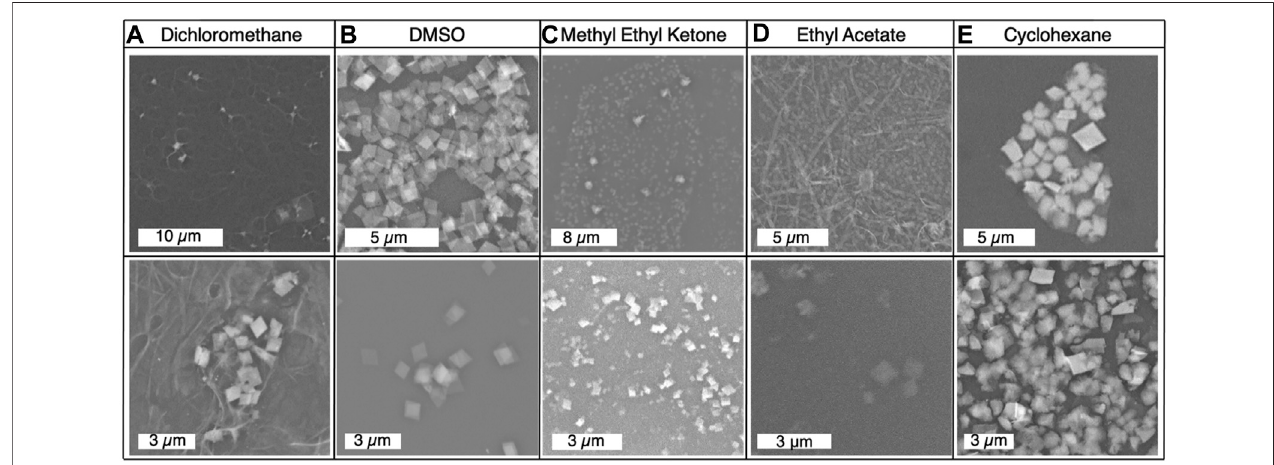
FIGURE 3 | (A) – (E) Scanning electron micrographs of each product from the solvent exchange syntheses, with products imaged from both dropcasted sample and interface harvested sample using the scooping